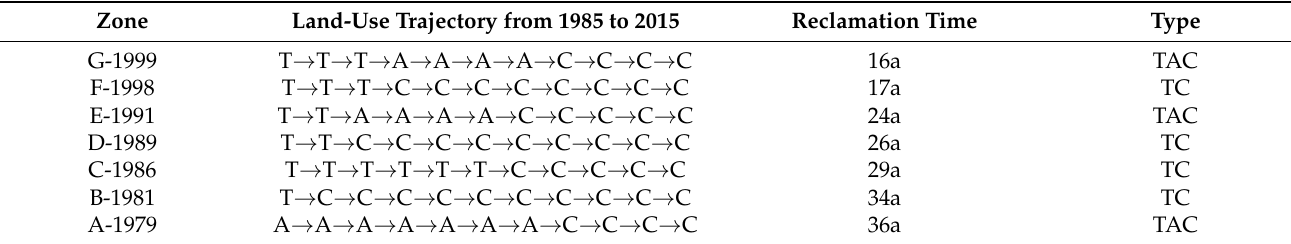
Table 1. Land-use trajectory from 1985 to